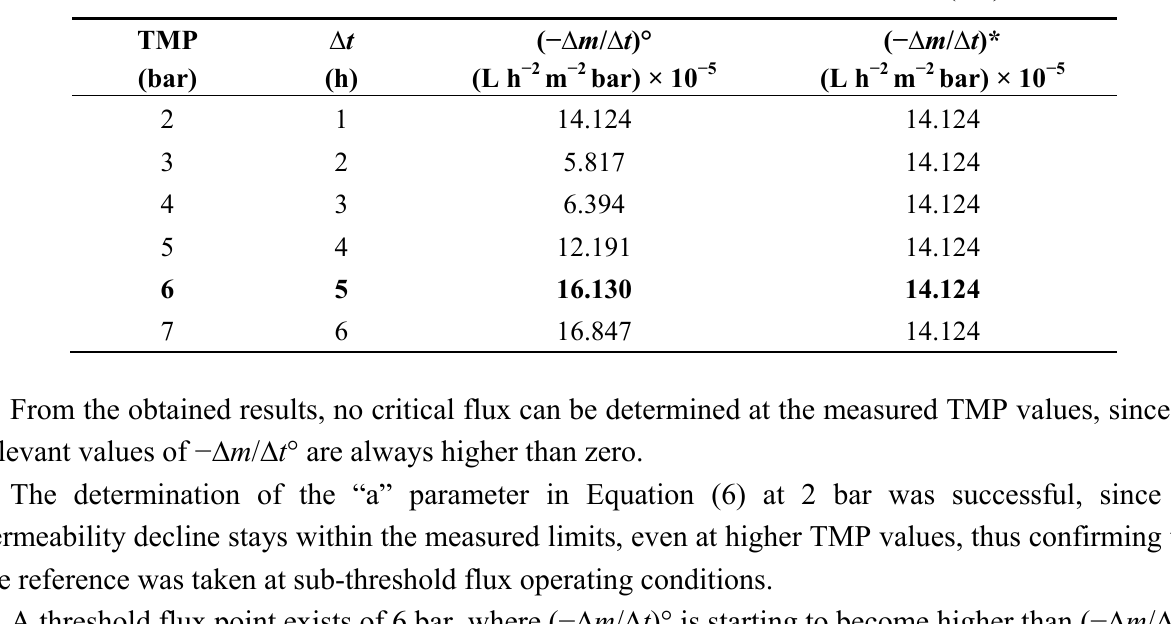
Table 3. Determination of the critical and threshold flux for the nanofiltration (NF)